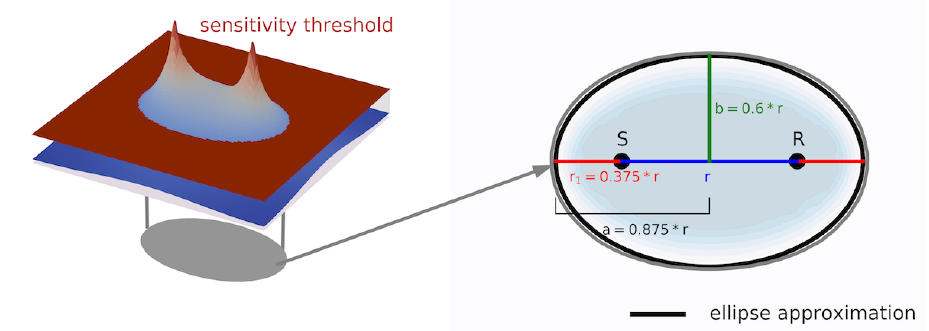
Figure 2. Graphical explanation of the derivation of the influence areas with the help of a sensitiv- ity